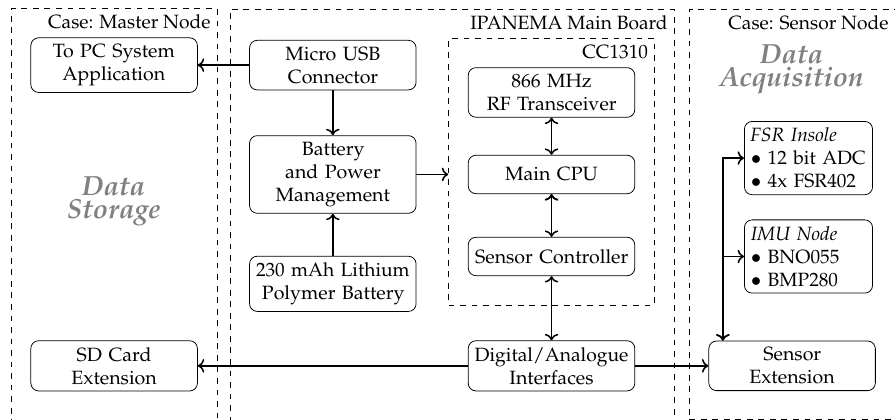
Figure 2. The IPANEMA mainboard can be equipped with either the master node extension board or a specific sensor board. The master board contains a USB port that establishes the data connection to the corresponding PC application. The sensor board is equipped with different types of sensors depending on the target